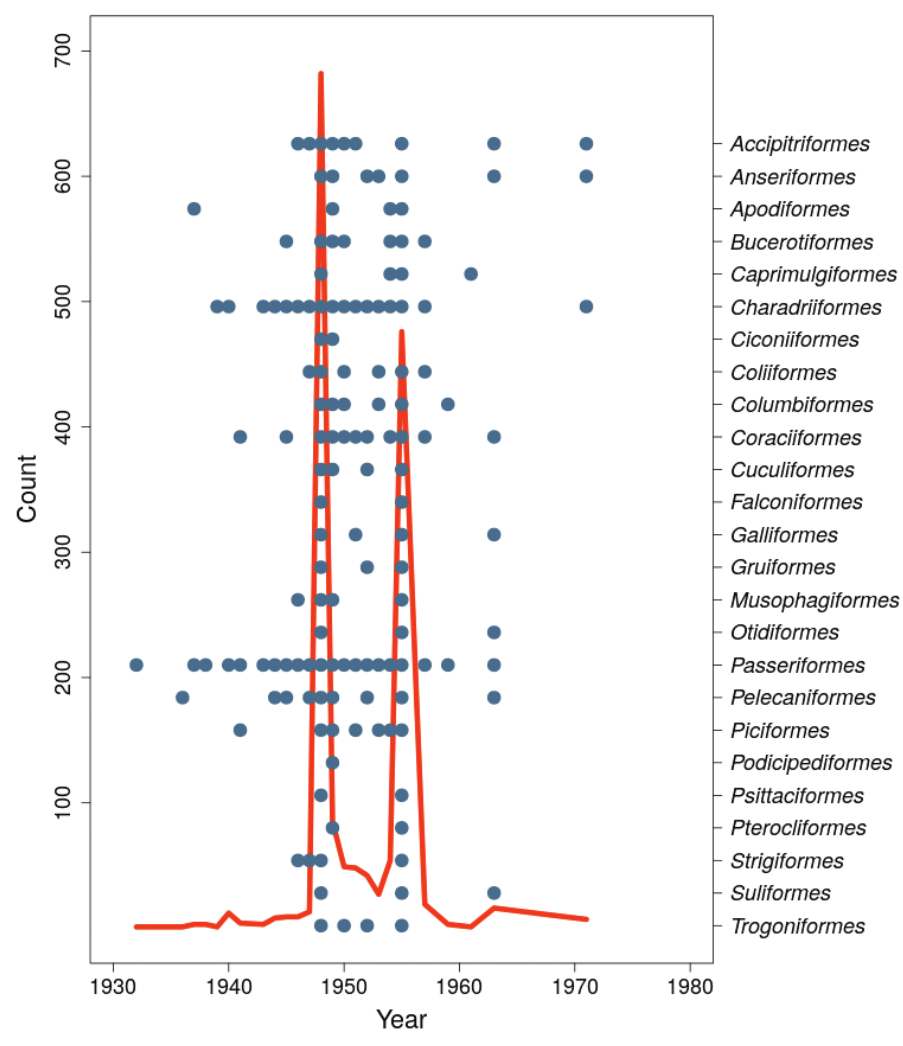
Figure 3. Temporal profile of the sampling leading to bird skin collection held at the zoological collec- tions of IICT-ULisboa (Lisbon). Blue dots represent sampling years for each